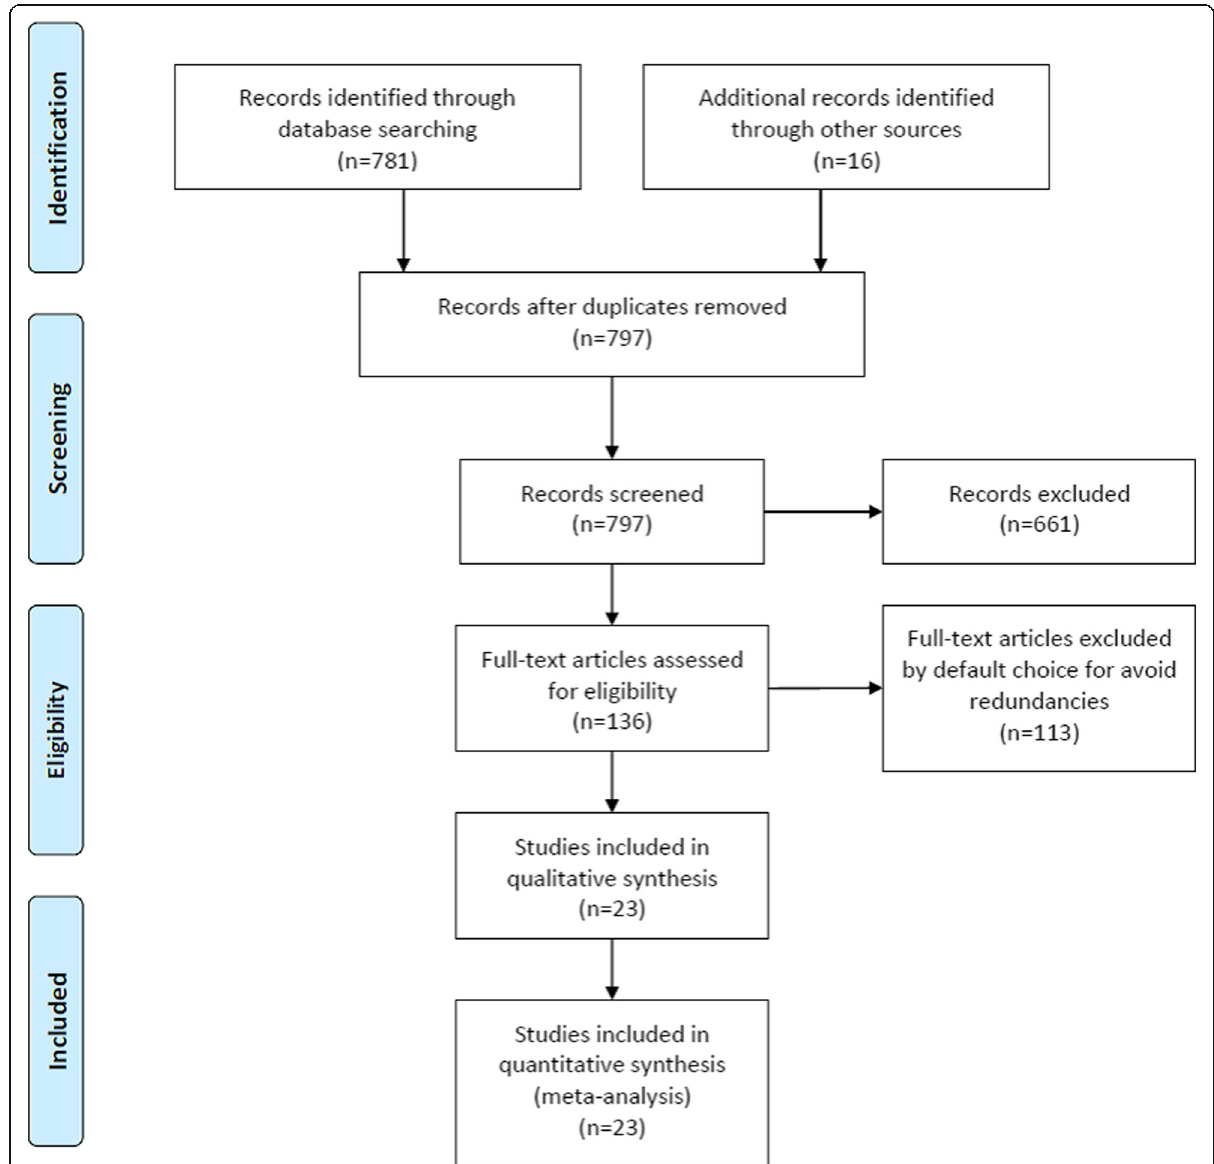
Fig. 1 Research and reference classification using the PRISMA